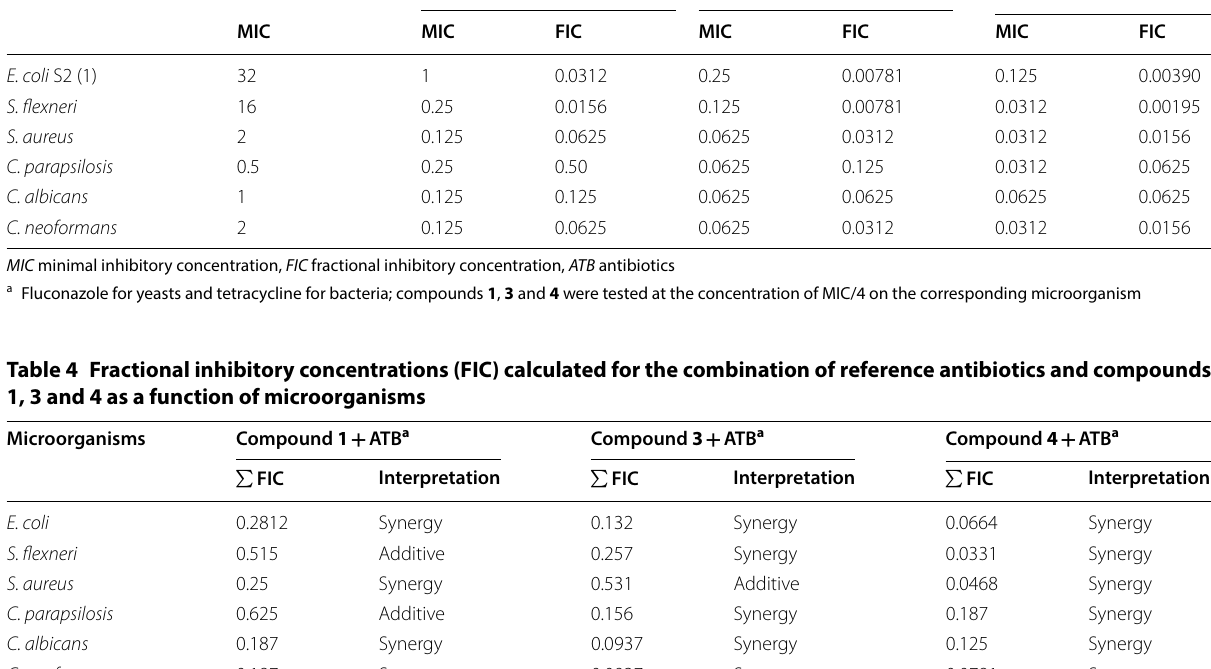
Table 3 Antimicrobial activities of the reference antibiotics in the presence of compounds 1, 3 and 4 at 1/4 of MIC as a function of microorganisms Microorganisms